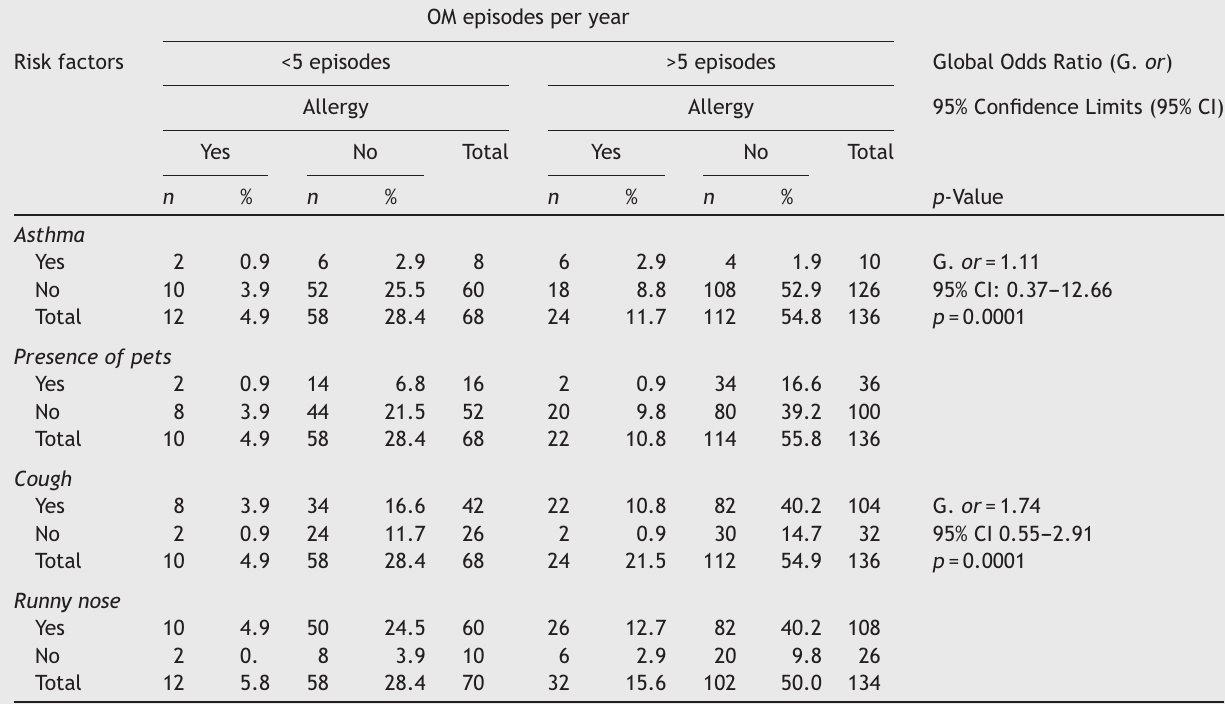
Table 2 Cases: allergic vs. non-allergic. Multivariate logistic regression analysis of OM recurrences. OM episodes per year Risk